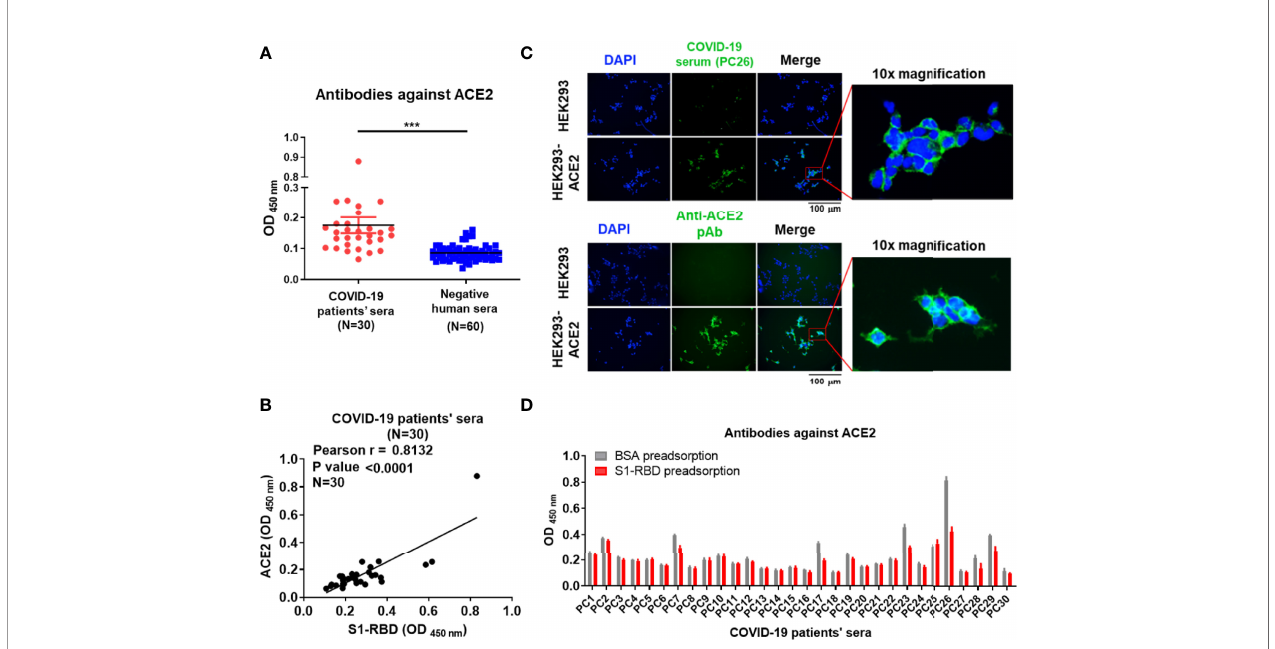
FIGURE 1 | Antibodies against S1-RBD in sera from patients with COVID-19 cross-react with ACE2. (A) The binding of sera (1:400 dilution) collected from 30 SARS-CoV-2-infected patients or 60 healthy humans to ACE2 was analyzed by ELISA using ACE2-His-coated plates. (B) Correlation of the OD of anti-S1-RBD (x- axis) and anti-ACE2 (y-axis) antibodies in the sera of patients with COVID-19 (N=30). The binding ability was analyzed by indirect ELISA. (C) HEK293 and HEK293- ACE2 cells were fi xed and stained with either COVID-19-positive PC26 serum (1:400 dilution) or an anti-ACE2 pAb (5 m g/mL) and then visualized using an immuno fl uorescent assay. Scale bar = 100 m m. The right images were derived from the original photographs at 10× magni fi cation. The PC26 serum and anti-ACE2 pAb reacted with ACE2 expressing on the surface of HEK293 was visualized by fl uorescent secondary antibody in green. All statistical data are presented as the means±S.Ds. from at least two independent experiments. ***P<0.001 (D) The sera (1:100 dilution) collected from 30 SARS-CoV-2-infected patients were preadsorbed by either BSA or S1-RBD prior to binding to ACE2-coated plates. The binding ability of preadsorbed sera to ACE2 was analyzed by indirect